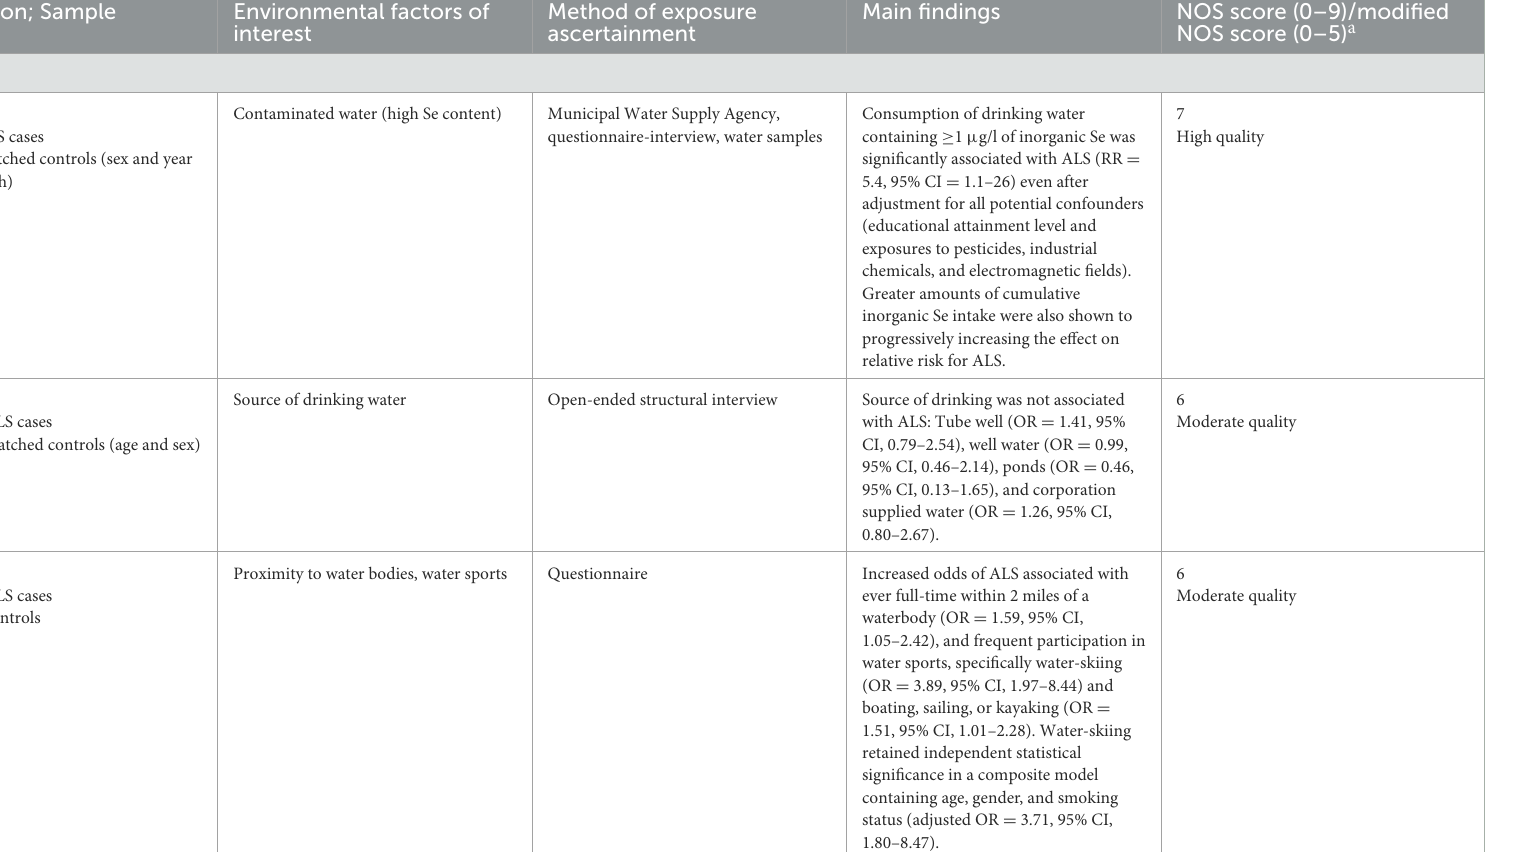
TABLE 4 Description of 14 included water pollution